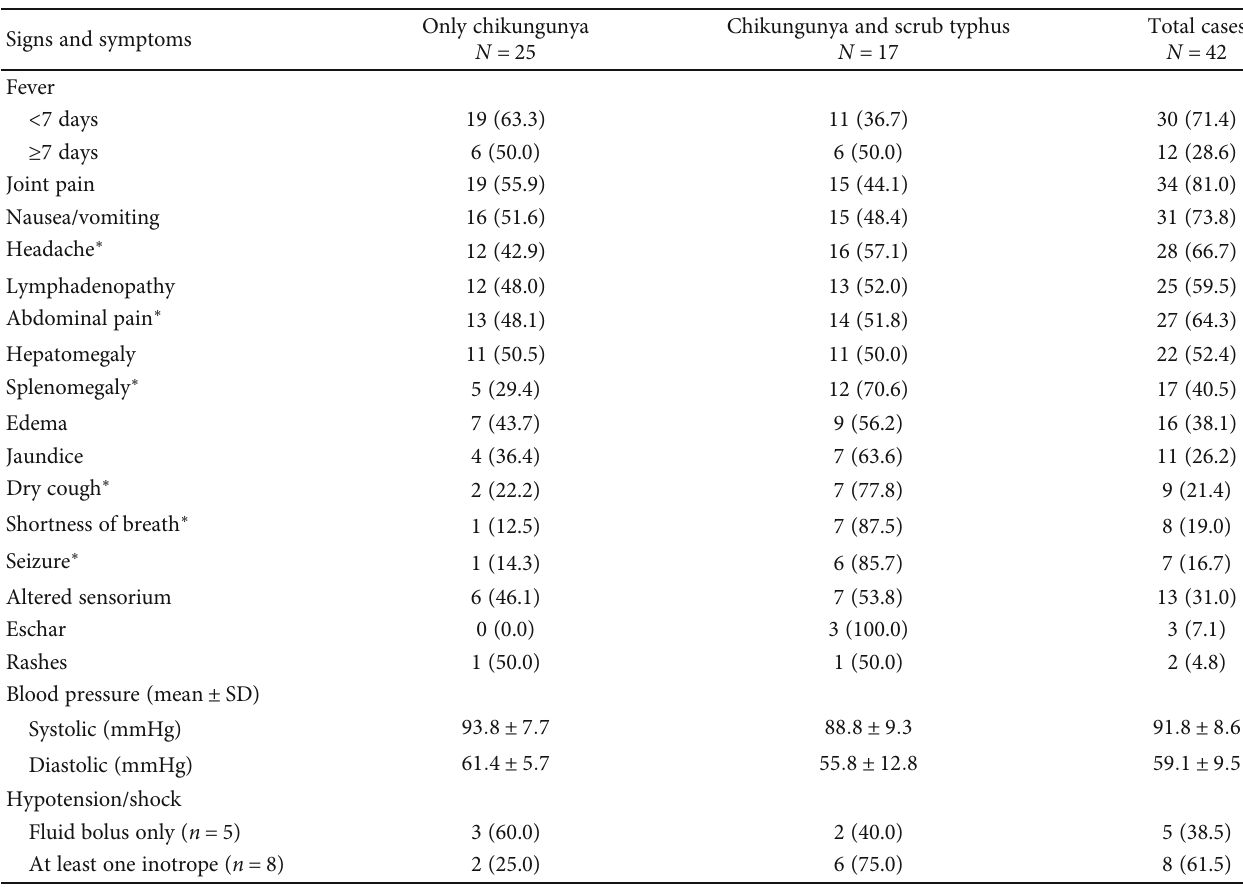
Table 2: Signs and